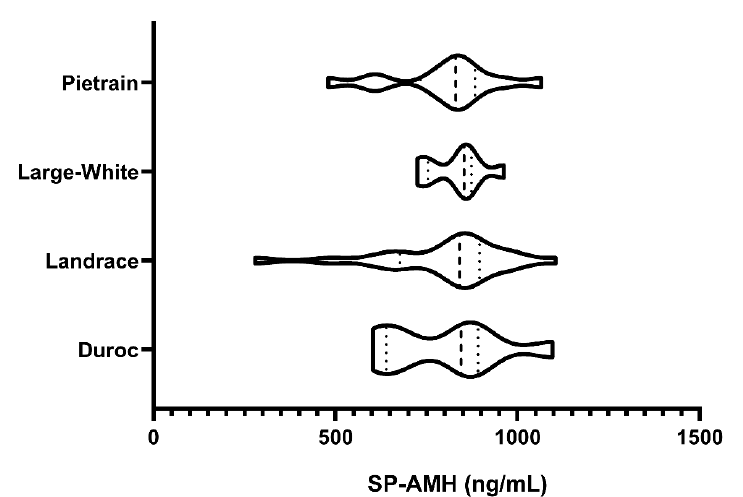
Figure 1. Violin plots representing concentration levels and distribution of the anti-Müllerian hormone (ng / mL) in seminal plasma (SP-AMH) from ejaculates (one per boar) of di ff erent pig breeds (Pietrain, n = 13; Large White, n = 9; Landrace, n = 19; and Duroc, n = 8). Dashed line represents the median and dotted lines the 25 and 75% quartiles. No significant di ff erences in SP-AMH concentration were found between breeds.